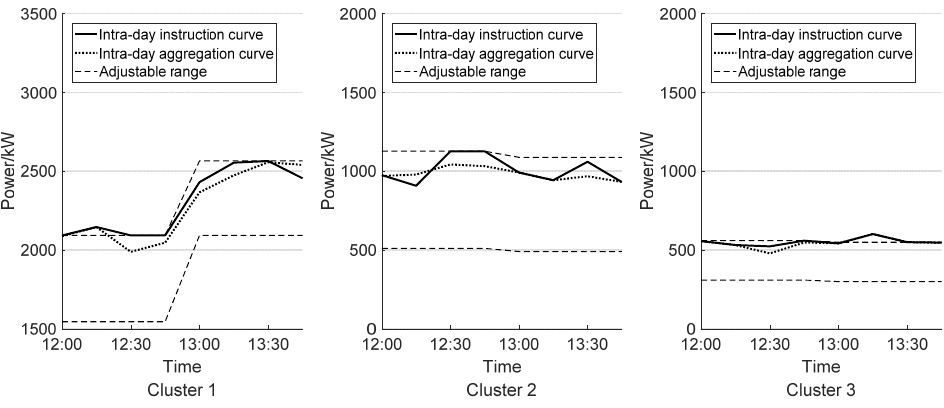
Figure 10. Intra ‐ day aggregation curve of each cluster. Figure 10. Intra-day aggregation curve of each cluster.